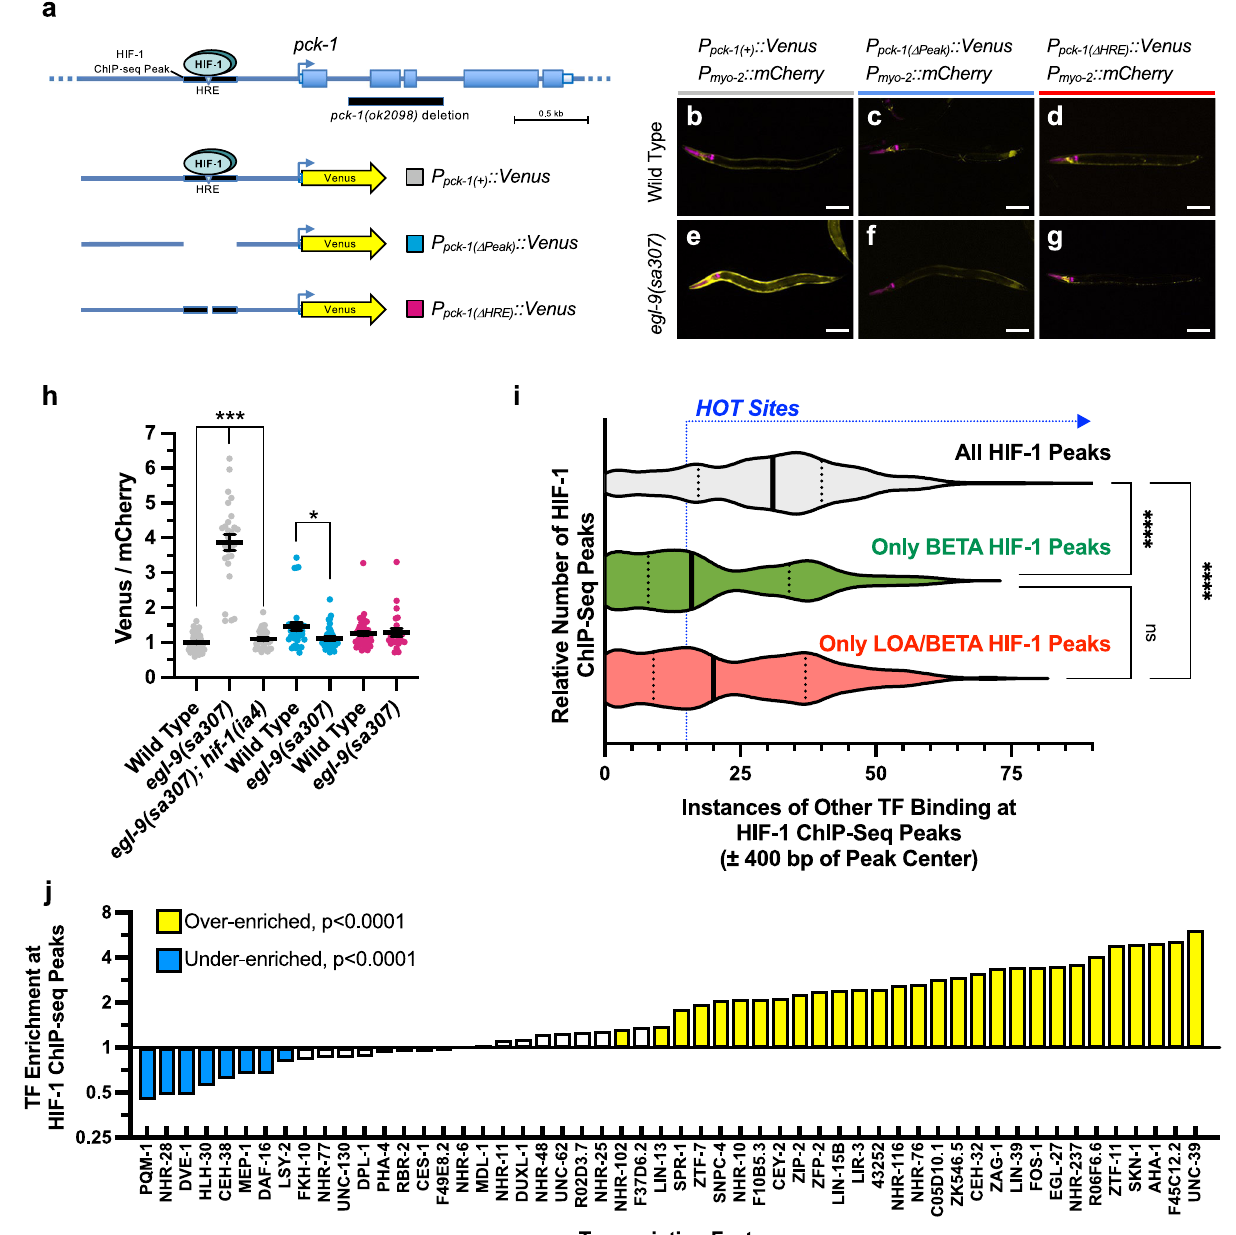
Fig. 2 | Characterizing HIF-1 binding sites. a Diagram of the pck-1 locus and the different promoters used to drive Venus expression. The oval indicates HIF-1, and the blacklinebeneathitindicates the HIF-1 binding site identi fi ed byChIP-seq. The invertedtriangleindicatesthesiteoftheHREmotif.ArrowsindicatetheTSS.Boxes indicate exons. The yellow arrow indicates sequences encoding the fl